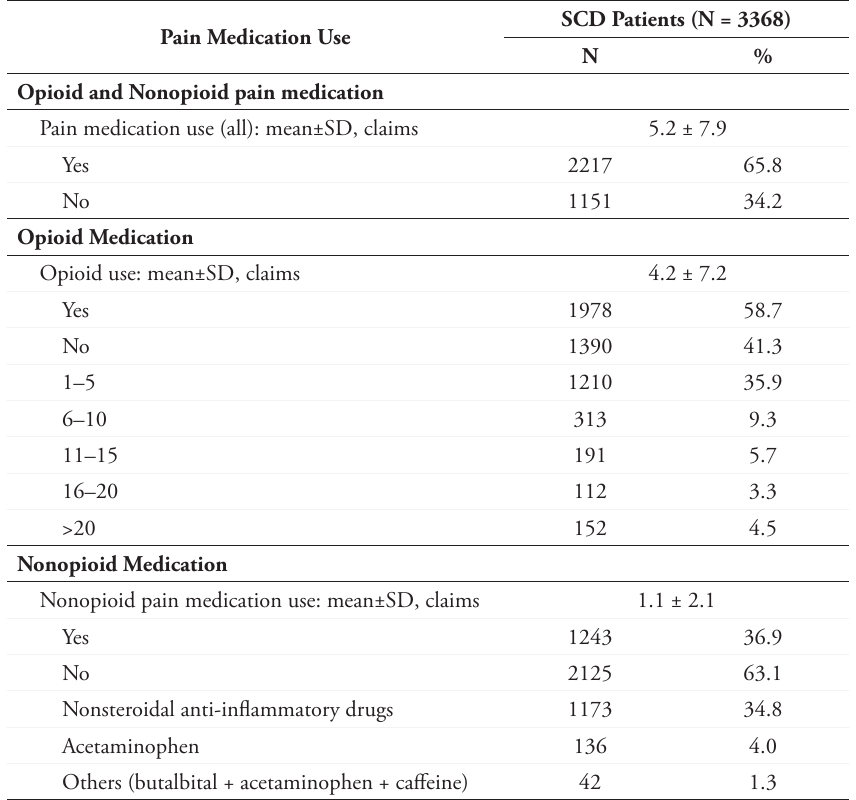
SCD Patients (N = 3368) N